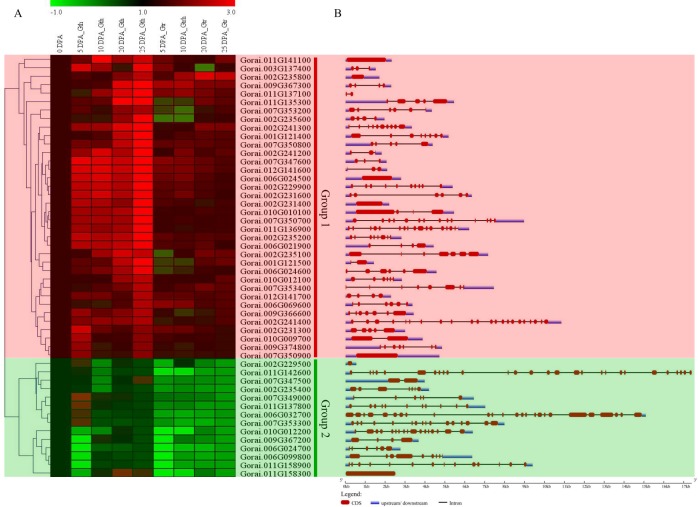
RT-qPCR validation of the selected genes.(A): Heat map for the 50 highly upregulated genes as per the RNA seq. The heat map was visualized using Mev.exe program (Showed by log 2 values). (i) Red-up regulated, green-down regulated and black- no expression. DPA: day post anthesis (B): Gene structure analysis of the 50 selected genes. Abbreviation: DPA: day post anthesis; Gth: Gossypium thurberi; Gtr: Gossypium trilobum.